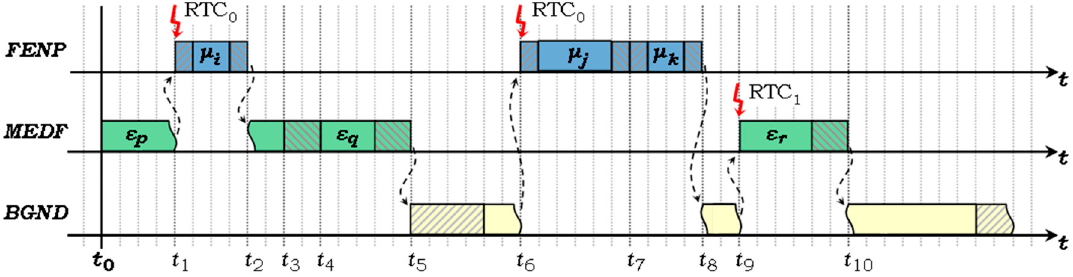
Figure 1. Execution contexts and system operation under the H 2 RTS method.